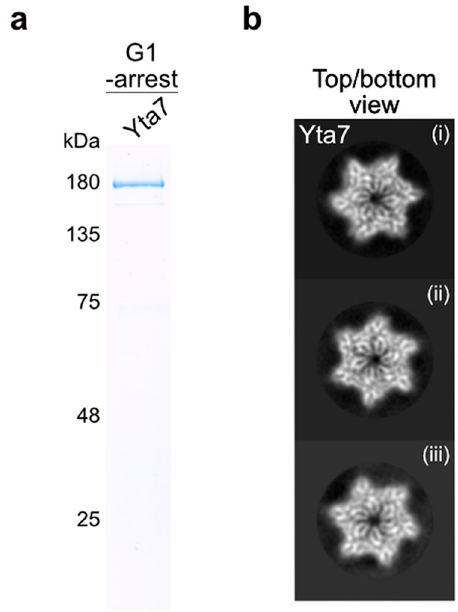
Fig. 2 Yta7 is related to molecular segregases. a SDS-PAGE and Coomassie staining of puri fi ed Yta7 from G1 phase cells. b ((i) – (iii)) Representative 2D-class averages of Yta7 puri fi ed as in a . Particle diameter is approximately 150